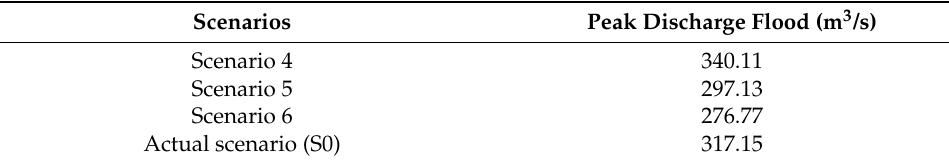
Figure 11. Flow curve of scenarios 4, 5, and 6, and the actual scenario (S0). Table 6. Peak discharges of scenarios 4, 5, and 6, and the actual situation